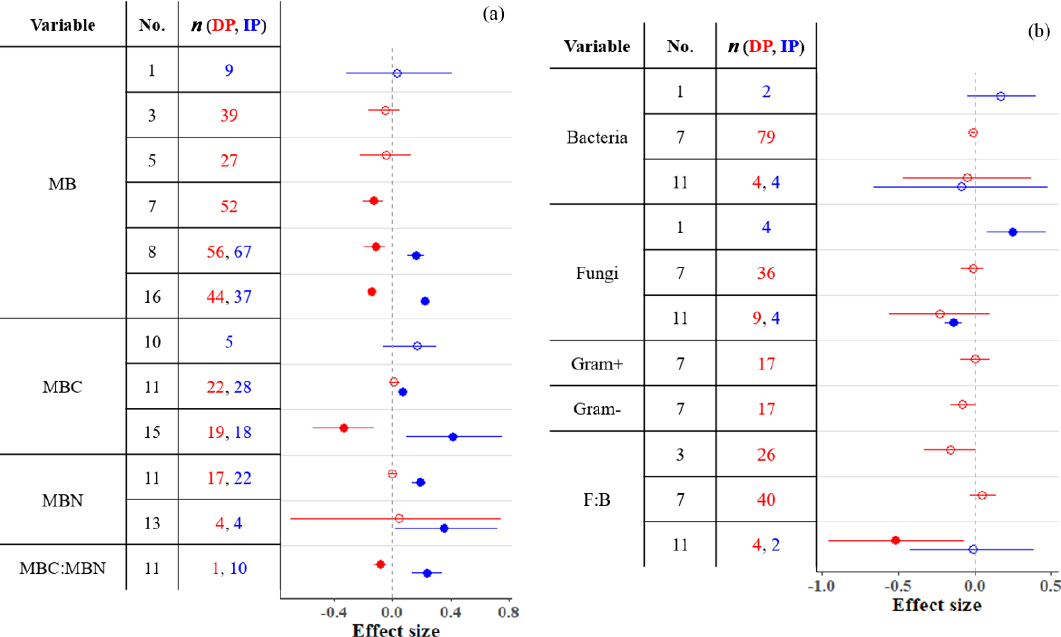
Figure 5. Effect sizes for (a) microbial biomass, carbon, and nitrogen and (b) bacterial and fungal variables responding to decreased (red) and increased (blue) precipitation. Filled points represent significant effect sizes (95% CI not overlapping 0), and open points represent nonsignificant effect sizes. Variable names correspond to Table 2. No. is meta-analysis number as listed in Tables 1 and 2. The sample size is indicated by n